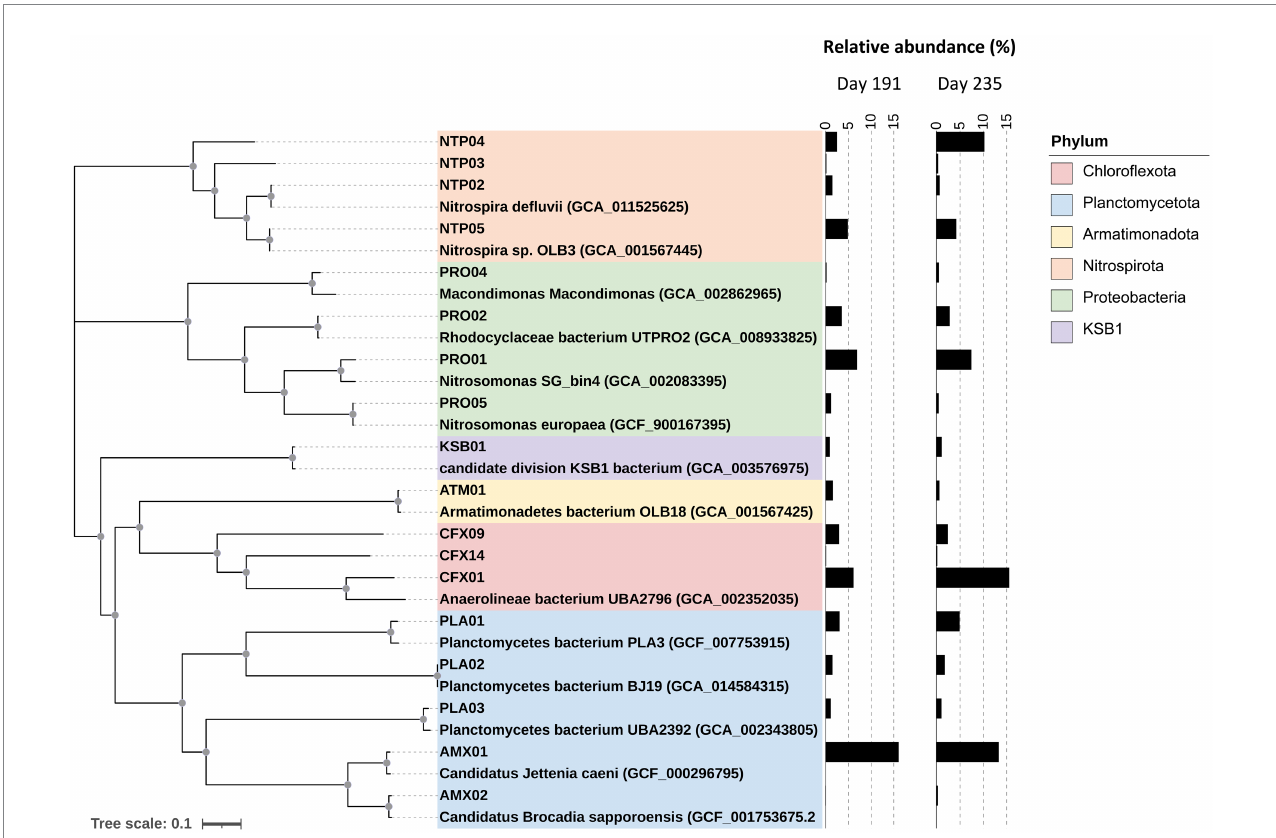
FIGURE 1 Phylogenomic analysis of 18 core MAGs based on the amino acid sequence of 34 single-copy marker genes. The phyla-taxa of these MAGs are indicated by colored boxes and their relative abundances are shown in the bar plot. The nodes with a bootstrap value higher than 90% are indicated as grey solid